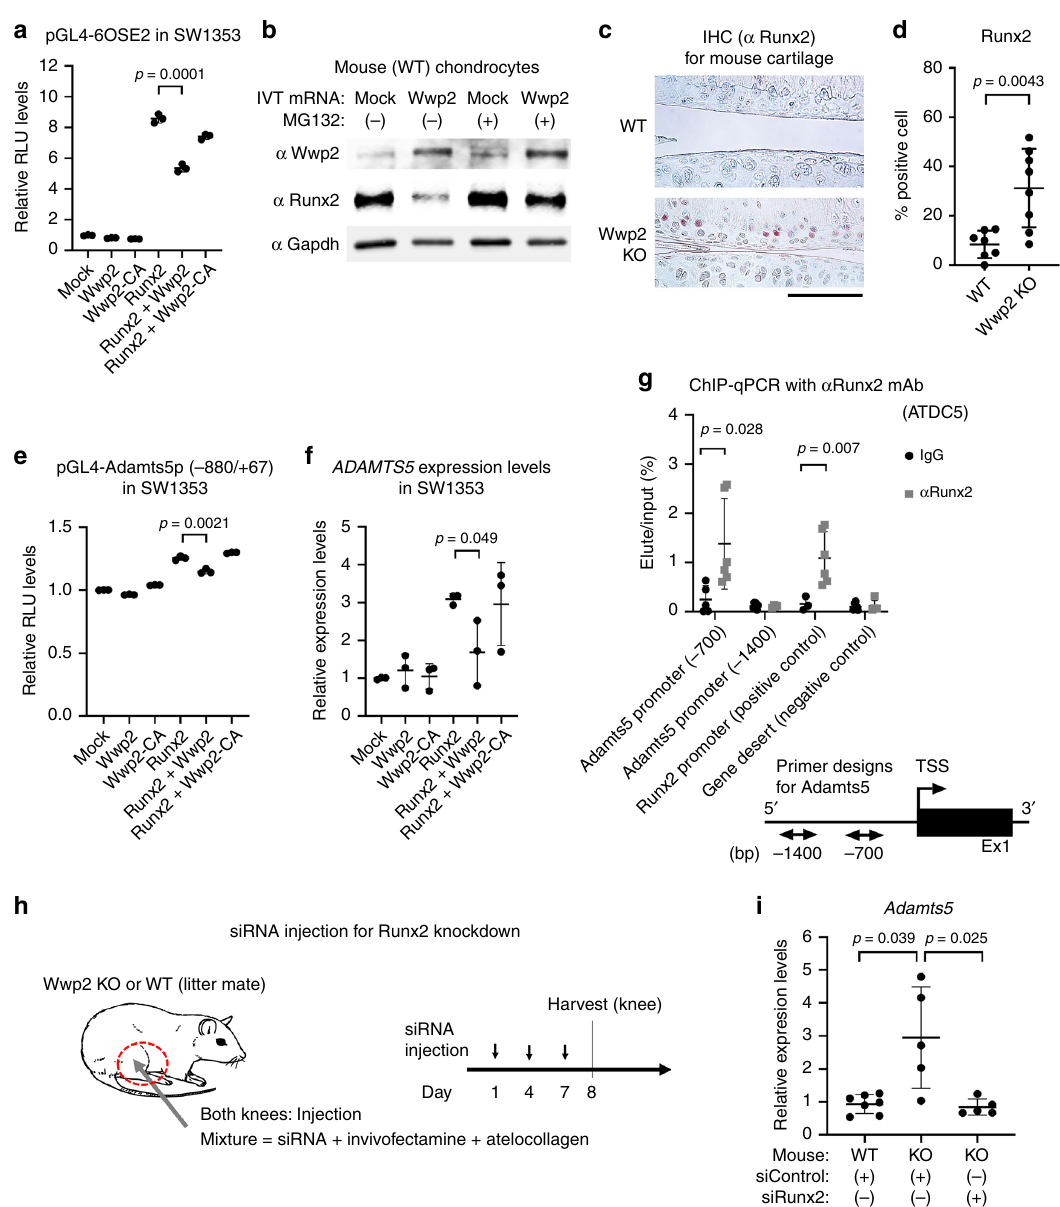
Fig. 4 E3 ligase activity of Wwp2 regulates Adamts5 through degradation of Runx2. a Runx2 reporter luciferase assay (pGL4-6OSE2) using SW1353 cells transfected with plasmids (Runx2, Wwp2, Wwp2-C838A (Wwp2-CA)) ( n = 3, Student ’ s t test). b Mouse chondrocytes were transfected with IVT Wwp2 mRNA ( ψ , 5mCTP) and treated with protease inhibitor MG132 (2 μ M, 60 minutes). This experiment was performed two or more times. Representative images are shown. c , d IHC of Runx2 for mouse articular cartilage (6-month-old). c Representative images. Runx2 was stained with Vector Red (red). d Runx2 positive cell rate ( n = 7 – 8, Welch ’ s t test). e Adamts5 promoter luciferase assay (pGL4-Adamts5p (-880/ + 67)) in SW1353 cells transfected with plasmids (Runx2, Wwp2, Wwp2-CA) ( n = 3, Student ’ s t test). f RT-qPCR for ADAMTS5 expression in SW1353 cells transfected with plasmids (Runx2, Wwp2, Wwp2-CA) ( n = 3, Student ’ s t test, normalized with GAPDH ). g ChIP-qPCR using anti-Runx2 antibody and ATDC5 cell line. The primer pairs enhanced Adamts5 promoter region (-700 or -1400 relative to the TSS), Runx2 promoter region (positive control) and gene desert (negative control) ( n = 6, Welch ’ s t test). h , i The in vivo knockdown experiment using siRunx2. Invivofectamine, atelocollagen and siRNA (siRunx2 and siControl) were injected into mouse knees. h Schedule of in vivo transfection. i RT-qPCR for Adamts5 expression levels in mouse cartilage ( n = 5-7, Dunn test compared with Wwp2 KO mouse treated with siControl, normalized with Gapdh ). Black scale bar = 1 mm. Source data are provided as a Source Data fi le. Data are presented